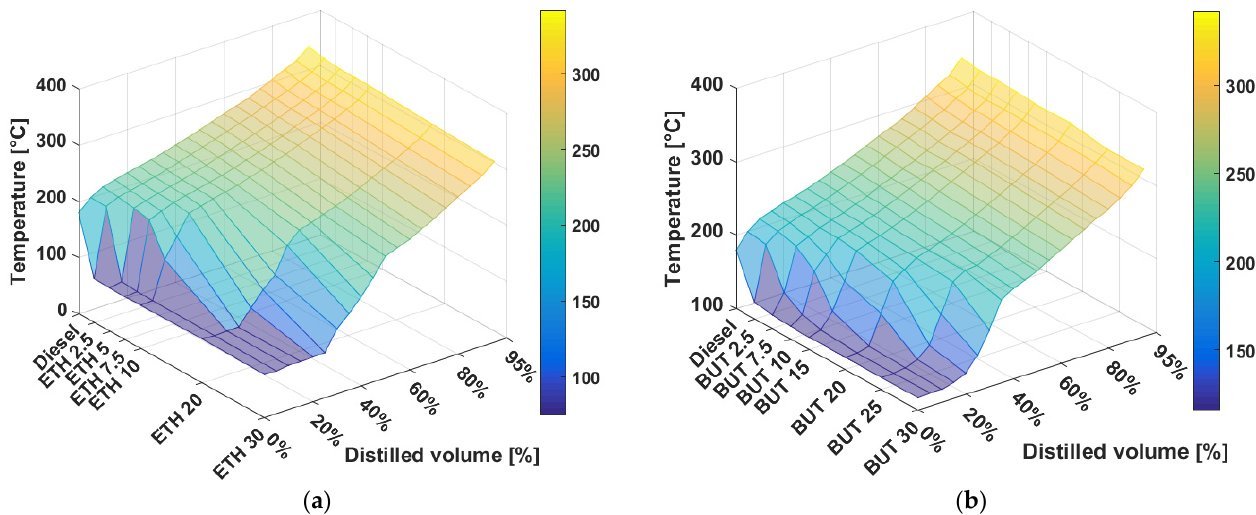
Figure 10. ( a ) Distillation curve of diesel fuel–ethanol mixtures; ( b ) distillation curve of diesel fuel–butanol mixtures.